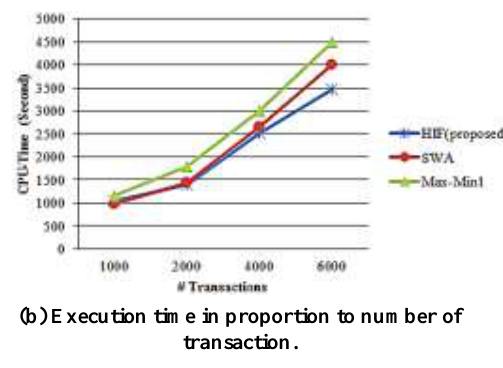
Figure 3. Execution time used by HIF, Max-Min1 and SWA.